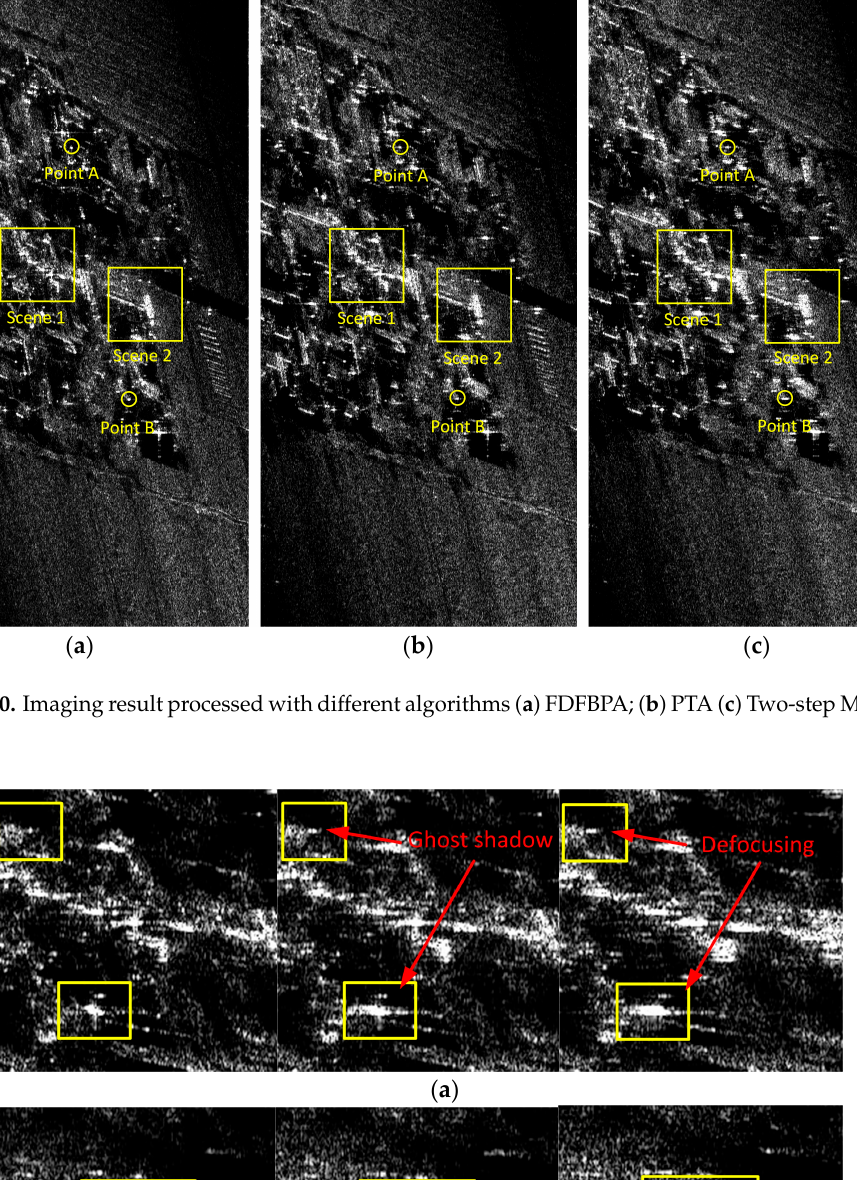
( b ) Figure 12. Azimuth pulse response curve comparison of FDFBPA, PTA and Two-step MOCO: ( a ) Scatter Point A; ( b ) Scatter Point B. Table 4. Comparison of Quantification Statistics Results. Approach